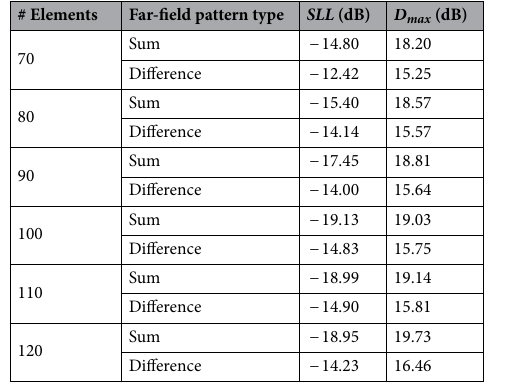
Table 1. Results of the optimization of linear arrays with common relative excitations for generating both sum and difference patterns, improving SLL and peak directivity ( D max ), without applying deep-null fixing strategies.